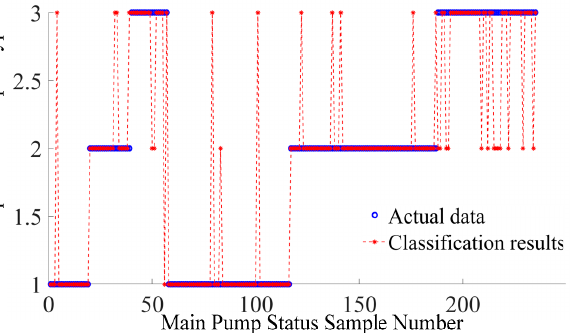
Figure 14. The result diagram of main pump health state identification based on EEMD-QGA-SVM.